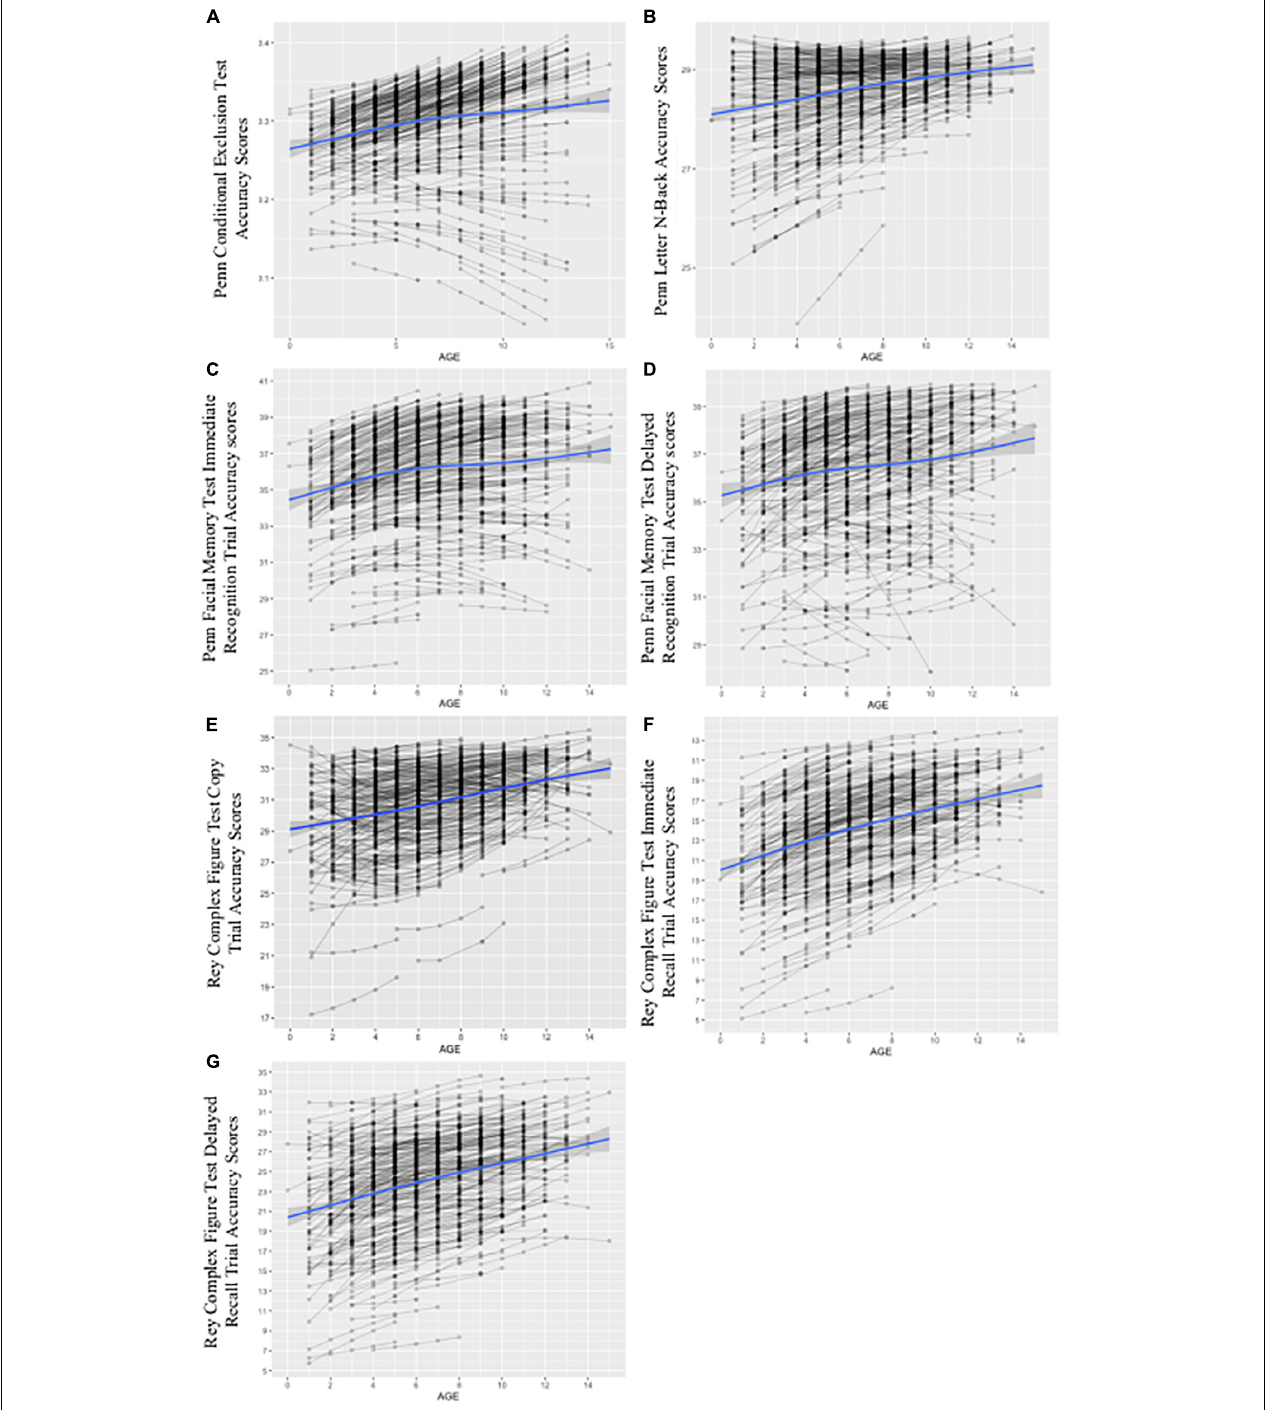
FIGURE 6 | Growth curves for conditional models including time-invariant covariates (TICs) and time-varying covariates (TVCs). The figure depicts spaghetti plots for final, multivariate growth curve models including all TICs (i.e., demographics) and TVCs (i.e., past-year alcohol use frequency and ARB history) for the PCET in panel (A) , PLBT in panel (B) , PFMT i in panel (C) , PFMT d in panel (D) , RCFT c in panel (E) , RCFT i in panel (F) , and RCFT d in panel (G) . The x-axis for panels (A) through (G) represents age as individually varying times of observation at each annual follow-up visit centered at 12 years, or youngest age at study entry. The y-axis represents respective test score scales with PCET scores ranging from 0 to 1 point, PLBT scores ranging from 0 to 30 points, PFMT scores ranging from 0 to 40 points, and RCFT trial scores ranging from 0 to 36 points. Individual participant test trajectories are represented by gray lines while the estimated growth curve is represented by the blue line with standard error shown in